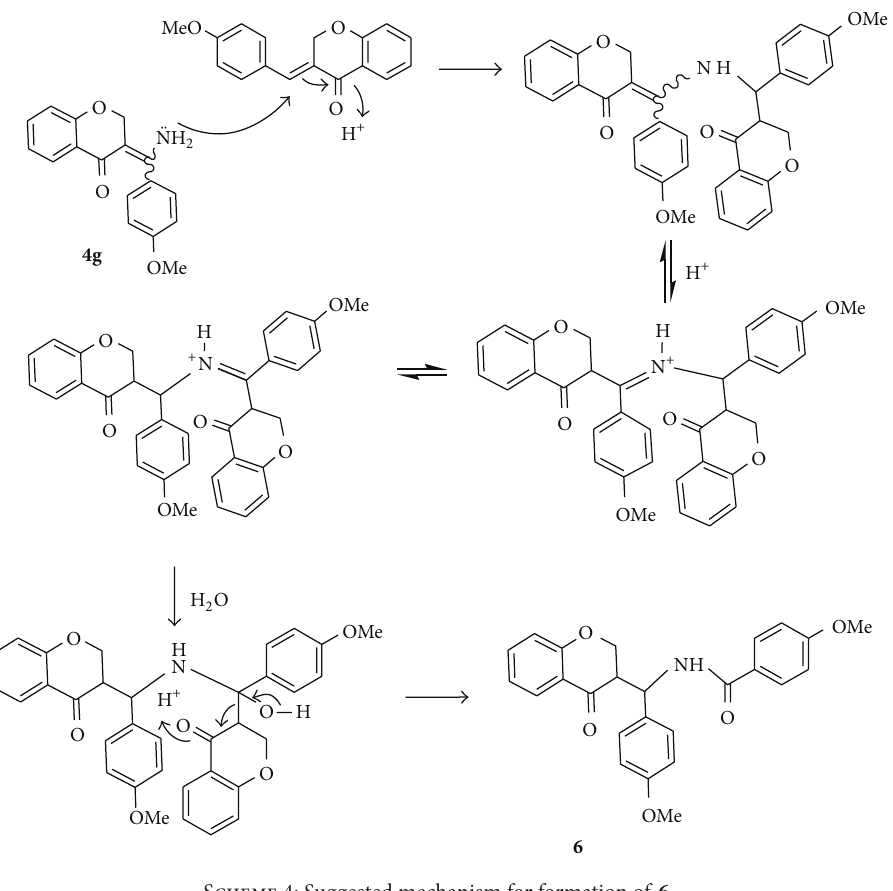
Scheme 4: Suggested mechanism for formation of 6